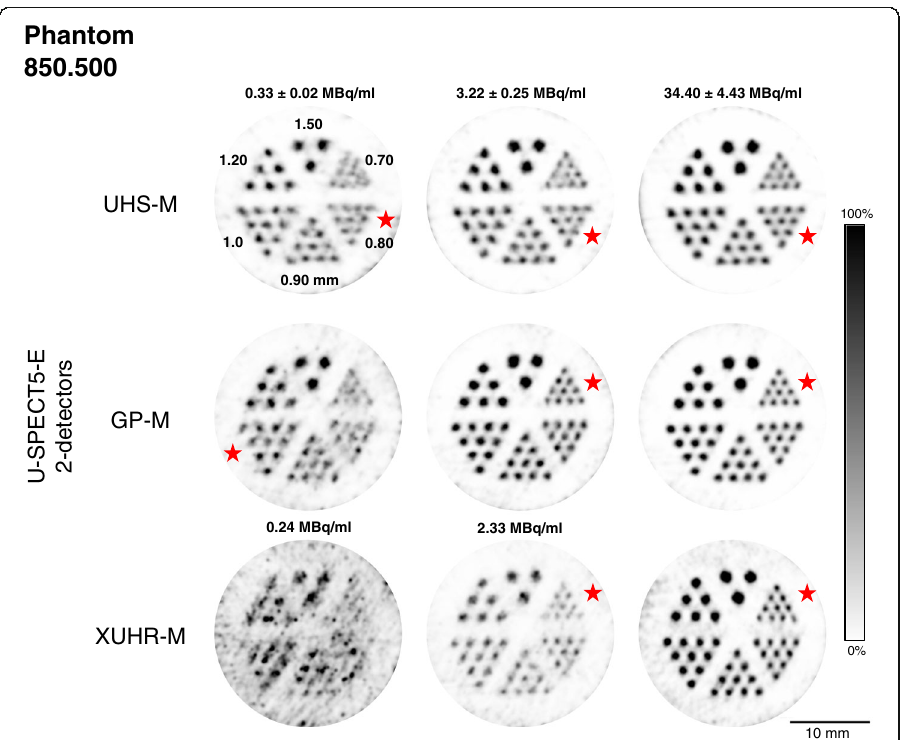
Fig. 6 Reconstructed SPECT images of the mini Derenzo phantom 850.500 with various activity concentrations (mean ± standard deviation) of 99m Tc for a 300 s TPB scan (10 BP). Rod sections marked with the red star were assumed to be the smallest diameter resolved. All images are shown with 6.0 mm slice thickness and 0.35 mm full width half maximum Gaussian